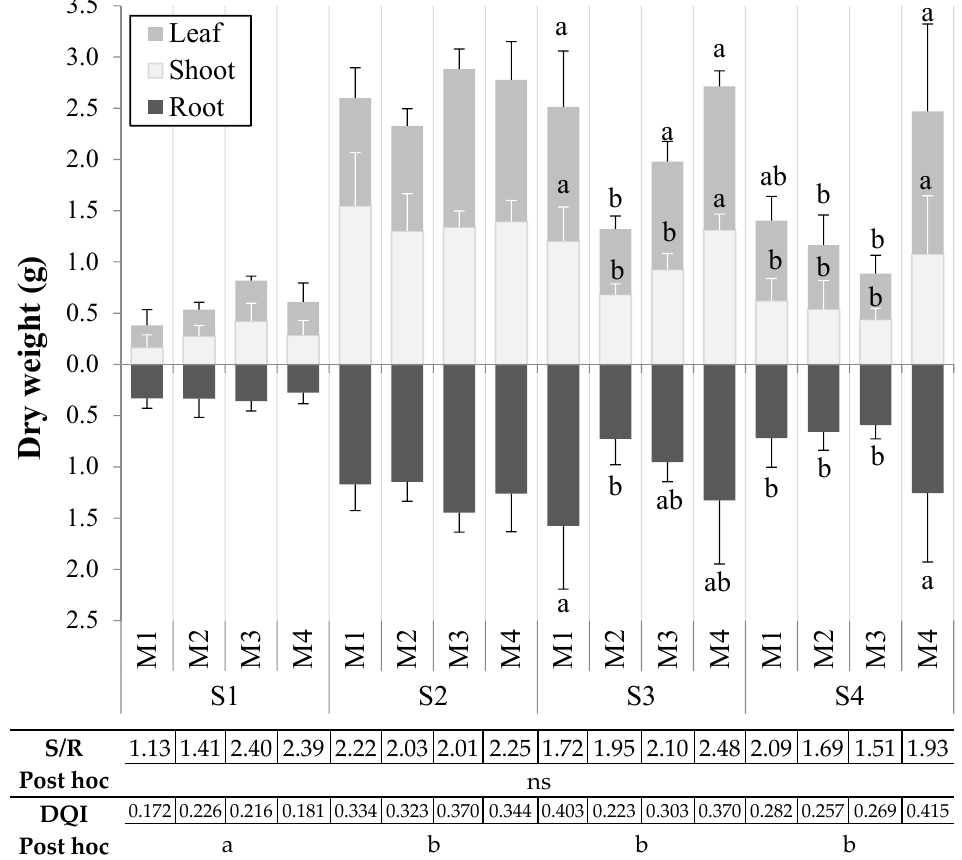
Figure 4. The effect of salinity (S) and medium (M) on the partition of roots, shoots, and leaf biomass of 14 week old Avicennia marina (Forssk.) Vierh., with additional information regarding S/R values and DQI of each treatment at the bottom. No significant differences (ns) at α 95% were observed between and among treatments for the S/R. Different letters under the DQI values indicate a significant difference at α = 0.05 between salinity treatments, whereas no significant differences were noted between medium compositions within the salinity ranges (ANOVA test in Table 4). Note: S1: